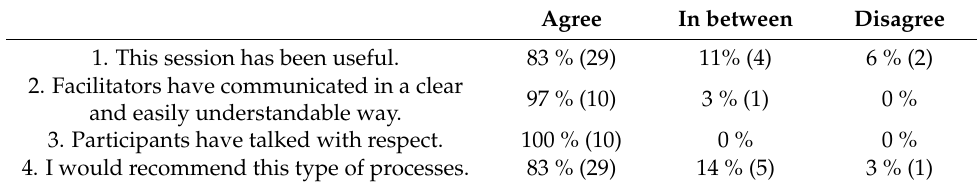
Table 4. Evaluation of the participation process (developed by the authors).